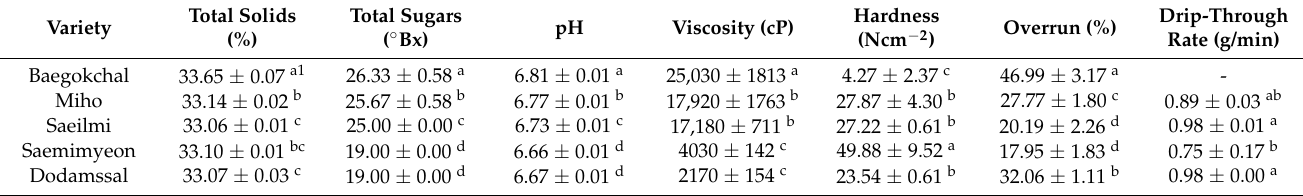
Table 2. Physicochemical properties of ice